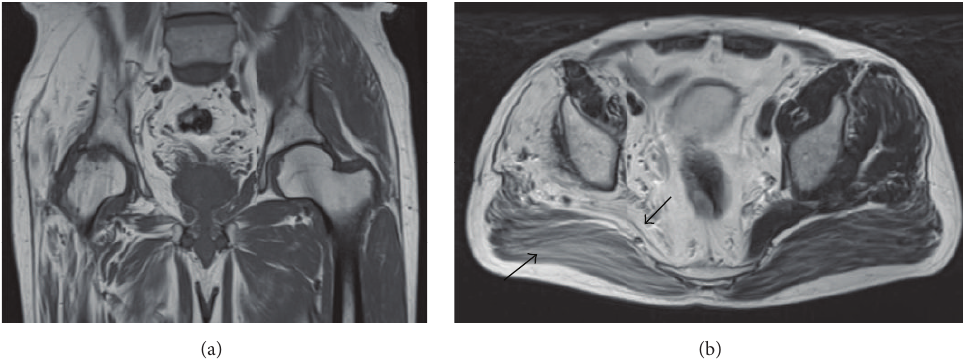
Figure 2: MRI of the hip taken 10 months after the starting of treatment: (a) coronal T1-weighted image showing low signal osteoarthritis change and (a and b) coronal T1-weighted and axial T2-weighted images showing homogeneous fatty signal changes in the gluteus medius muscle and similar appearance even in the other muscles